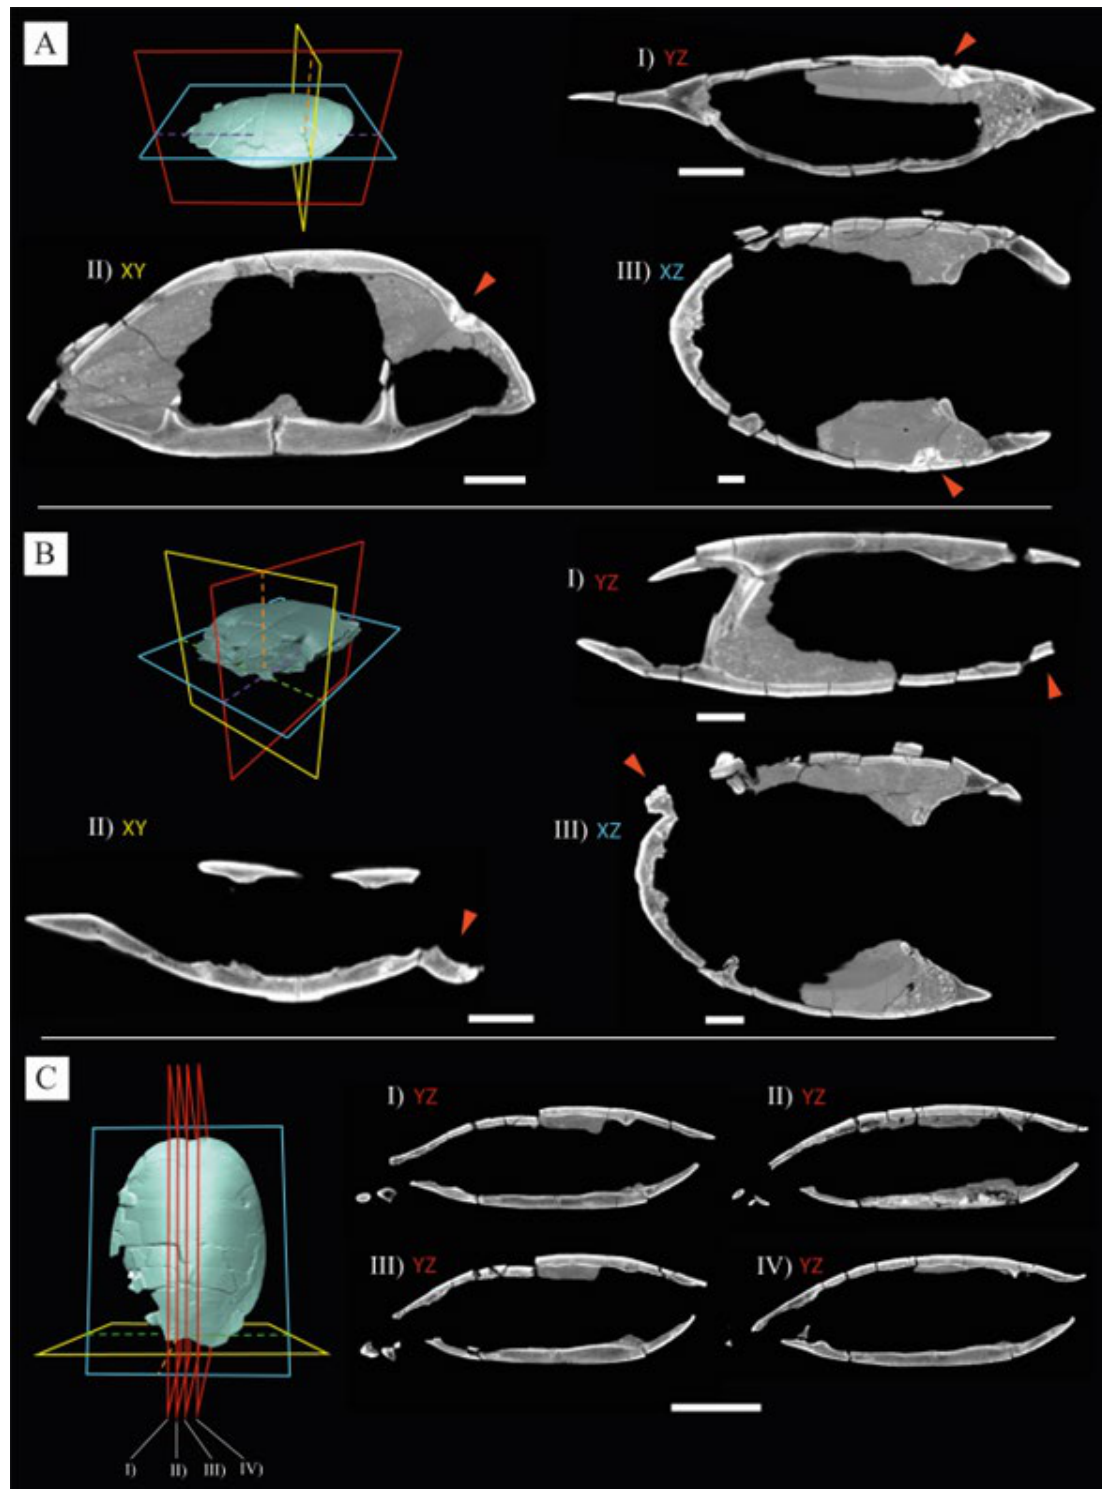
Figure 3. Cross-section slices of the shell of anomalous carapace of a Neochelys sp. (Pleurodira, Podocnemididae), STUS 14024, from the middle Eocene (Lutetian) El Tejar fossil site, at Corrales del Vino (Zamora, Spain). ( A ) cross-section of the hole: (I) and (II), perpendicular view of the shell anomaly; (III), parallel view of the shell anomaly. ( B ) cross-section of the seventh costal plate, which also lacks its posterior region. ( C ) cross-section of the abnormal condition of the posterior region of the carapace: (I–IV) perpendicular view of the carapace. Scale bars equal to 2.5 cm in ( A , B ), and 10 cm in ( C ).